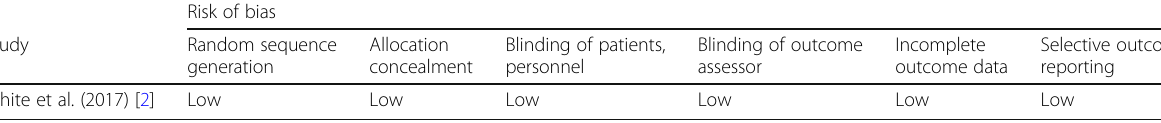
Table 4 Risk of bias of included